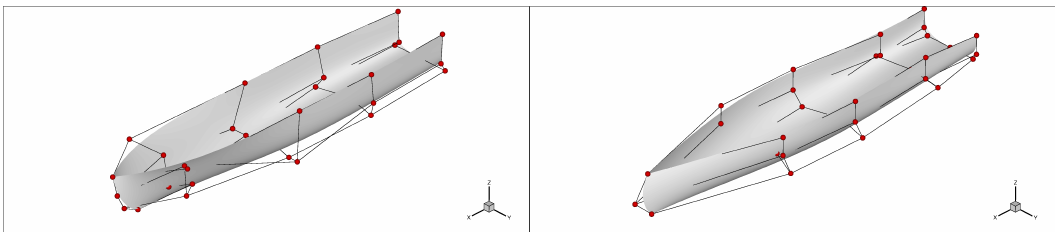
Figure 3. Representation of the hull surface adopted in the effective power optimization problem by means of a single NURBS: original shape (on left ) and optimal shape (on right ) obtained with a shift of the control points of the NURBS.